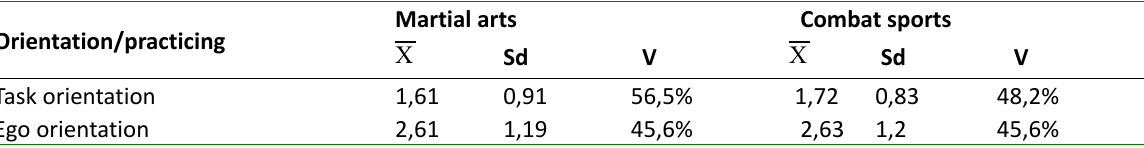
Table 3. Perceptions of success and type of cultivated martial arts practiced Orientation/practicing